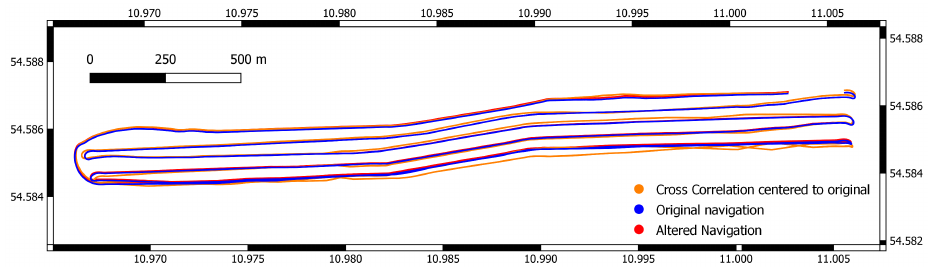
Figure 7. Survey with altered and readjusted navigation for trial 1 using different norms: cross correlation, L1, Huber and truncated quadratic.